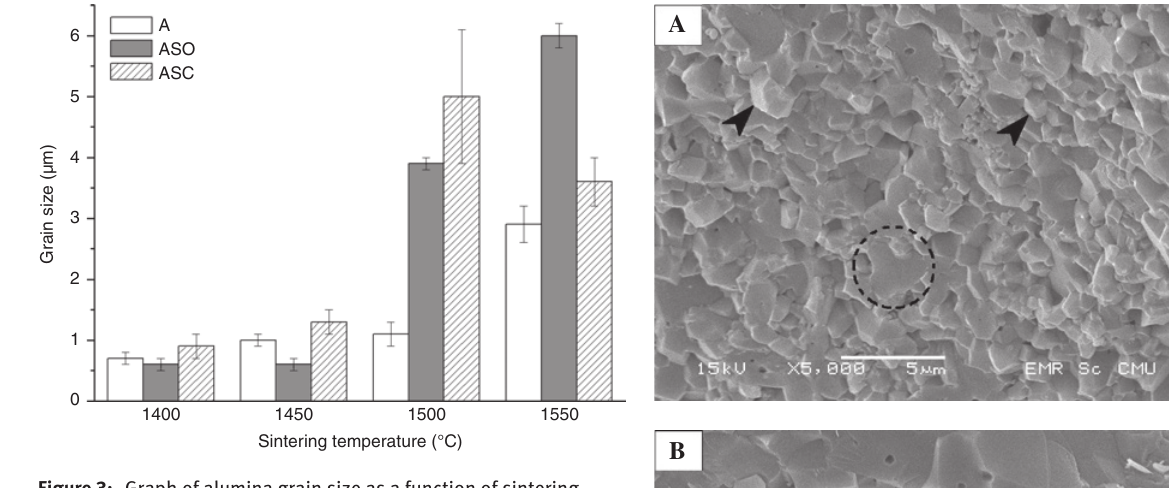
Figure 3: Graph of alumina grain size as a function of sintering temperature.